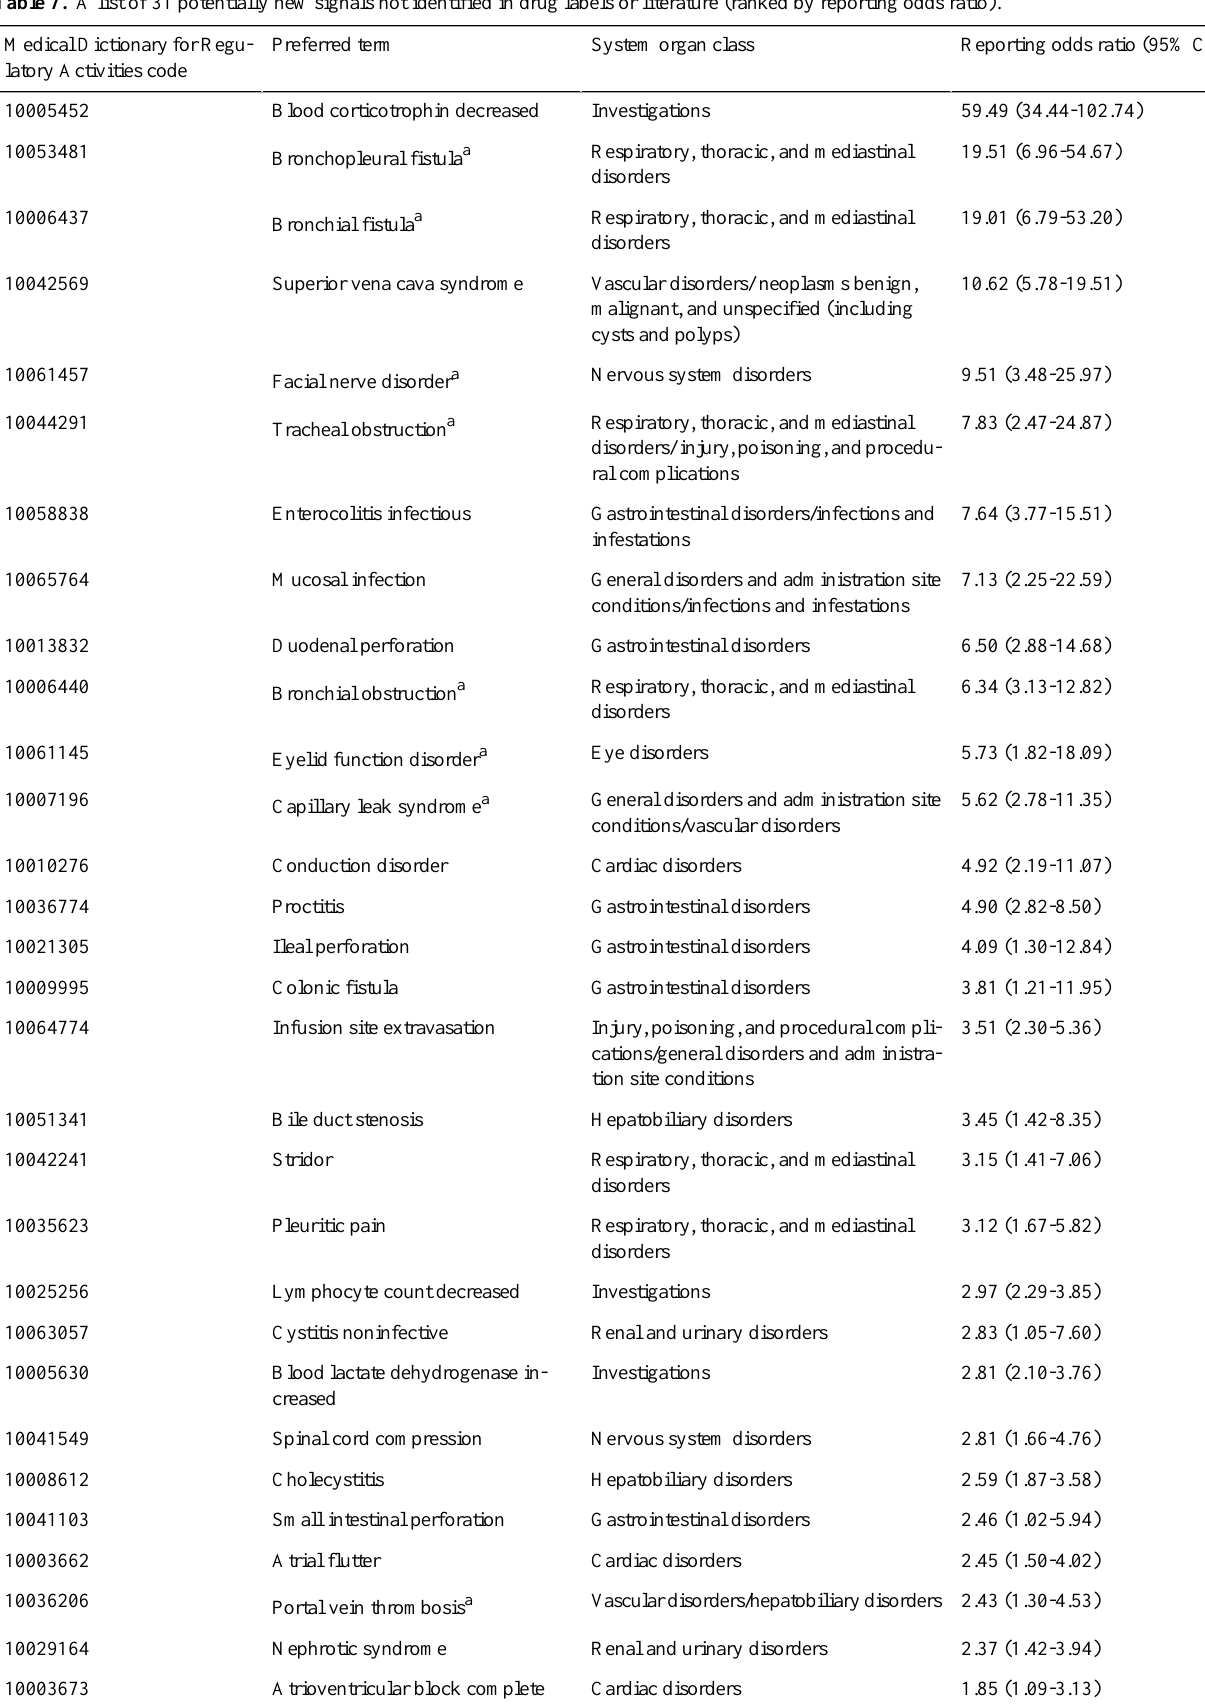
Table 7. A list of 31 potentially new signals not identified in drug labels or literature (ranked by reporting odds ratio). latory Activities